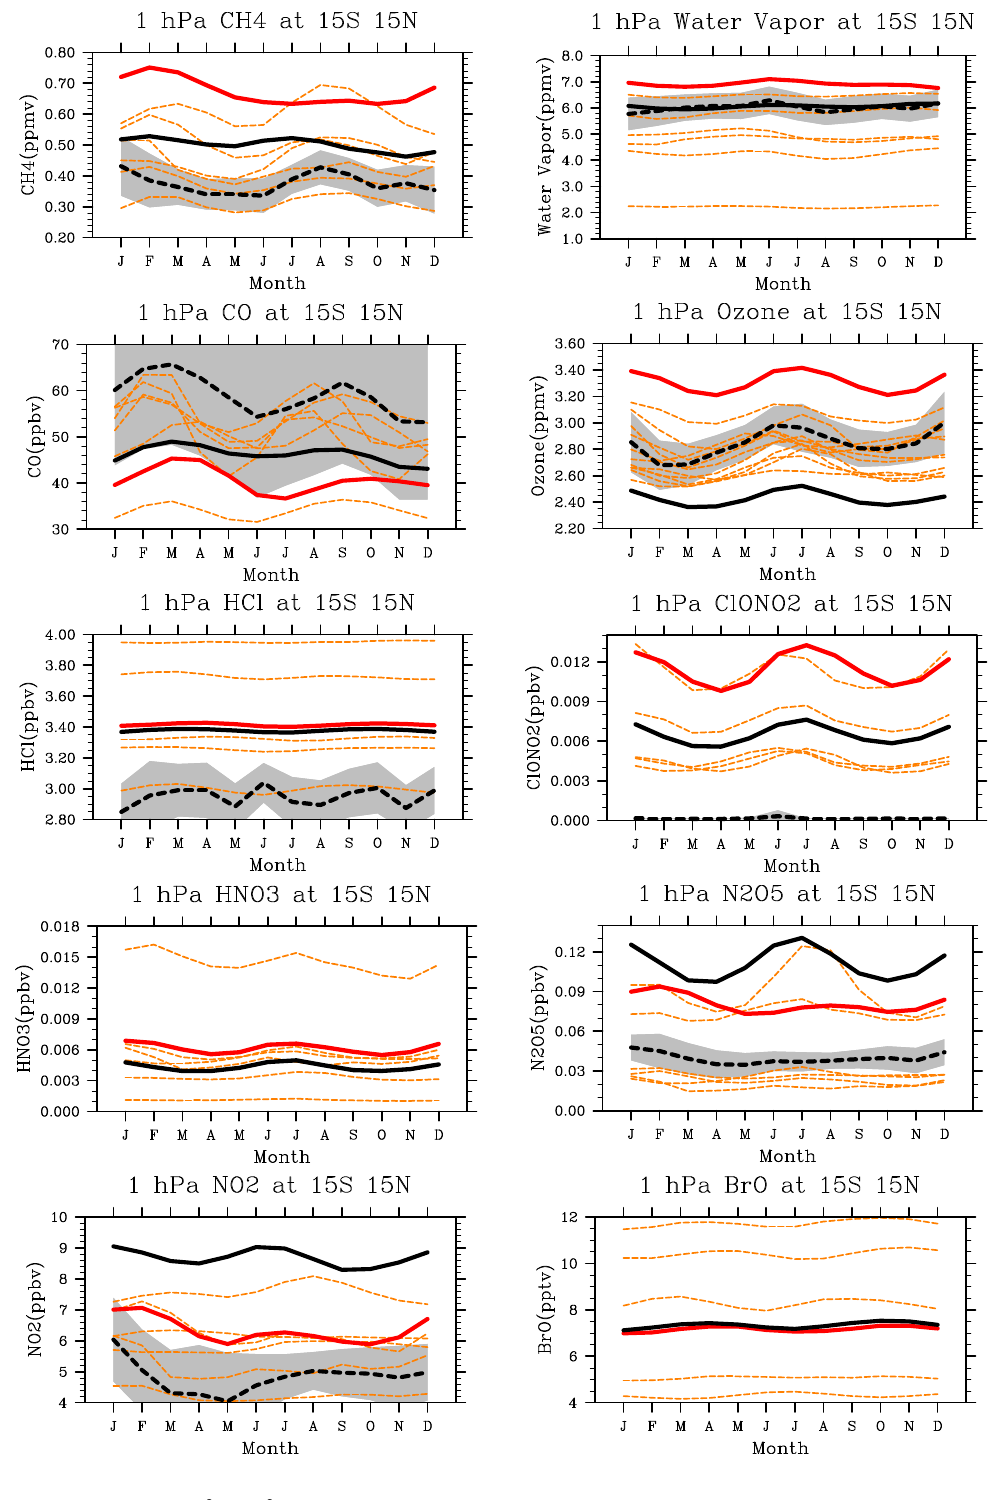
Fig. 17. Same as Fig. 12 at 1hPa, 15 ◦ S–15 ◦ N.